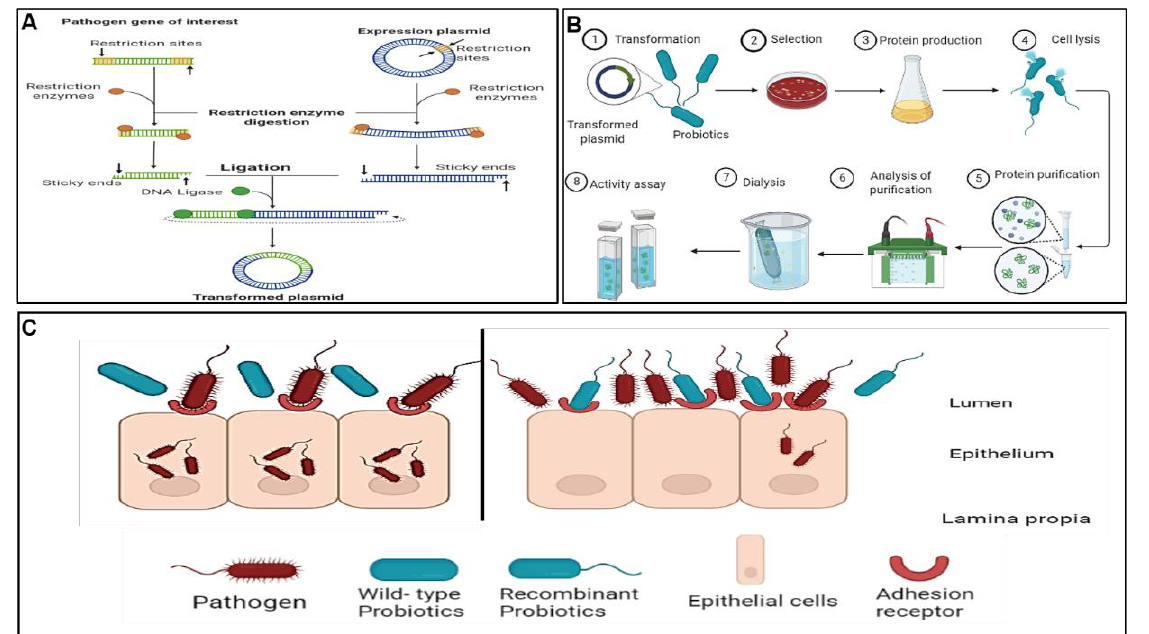
Figure 4. A schematic representation of the steps followed in development of bioengineered probiotics and the mechanism of pathogen inhibition by the bioengineered probiotic strain. ( A ) Cloning and expression of genes of interest from the pathogen into an expression vector. ( B ) Transformation of the expression vector carrying the gene of interest from the pathogen into the probiotic and analyses conducted to confirm expression of the foreign gene by the bioengineered probiotic strain. ( C ) Competitive binding of the bioengineered probiotic strain to the same host receptors to which the target pathogen binds to cause an infection.